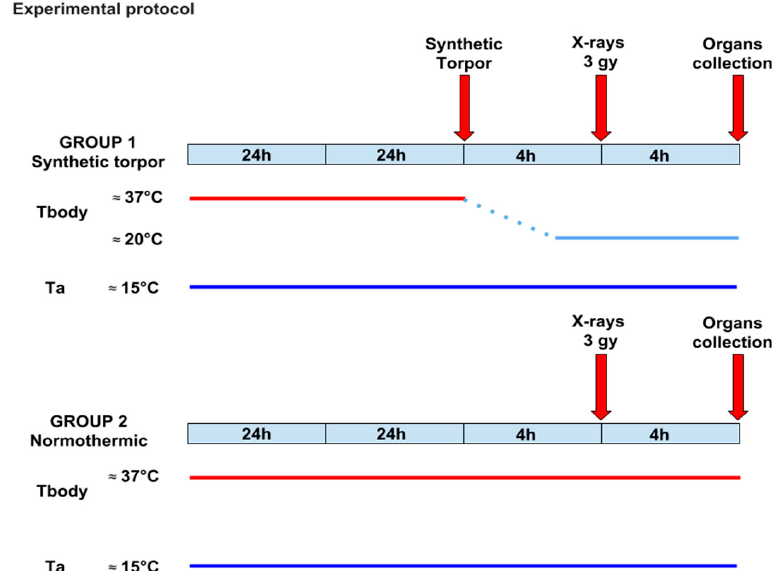
Figure 6. Experimental protocol. After at least one week of recovery from surgery, rats were moved to the experimental cage and exposed to a lower ambient temperature (15 ◦ C) 48 h prior to the experiment. At 07:00 of the experimental day, rats were randomly assigned to one of the experimental groups: Hypothermia ( n = 5) (Group 1), animals underwent multiple microinjections (1 / h, 100 nL) of the GABA-A agonist muscimol (1mM) within the RPa, whereas Control ( n = 5) (Group 2) were injected with artificial cerebrospinal fluid (ACSF). Four hours after the onset of synthetic torpor in the Hypothermia group, animals underwent a 3 Gy X-rays radiation exposure and were returned to the experimental cage for additional four hours. At 16:00, all animals were euthanized and organs were